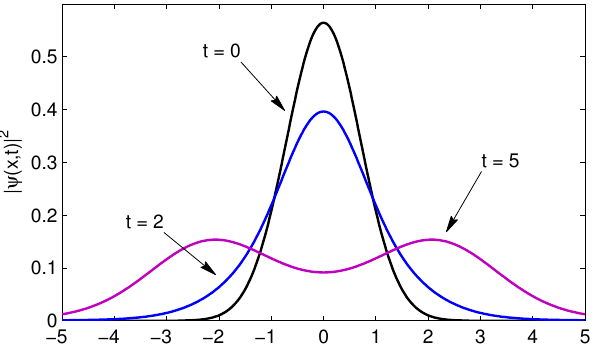
Figure 3. Time evolution of the Gaussian initial wave packet Equation (20) for the parameter σ =